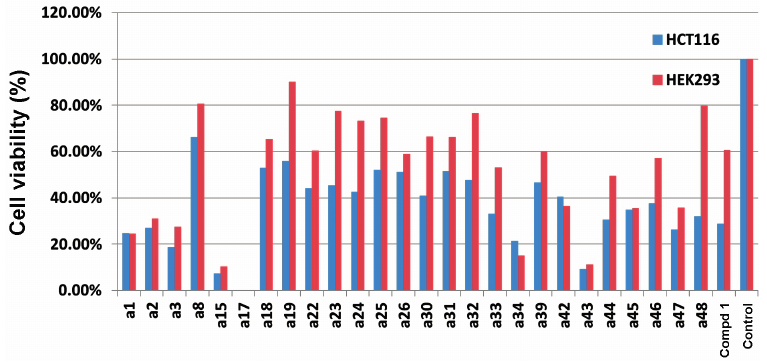
Figure 5. Results for 26 test compounds from cytotoxicity evaluation. Compounds were evaluated at 100 µM for their cytotoxicity against HCT-116 human colon cancer cells and HEK-293 normal human embryonic kidney cells. H-89 (Compound 1 ) was used as a reference compound in the